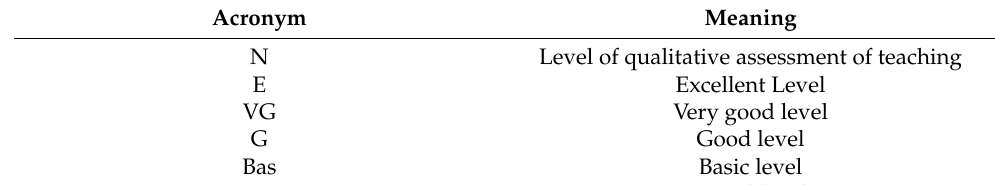
Table 6. Acronyms used in the application of fuzzy rules.